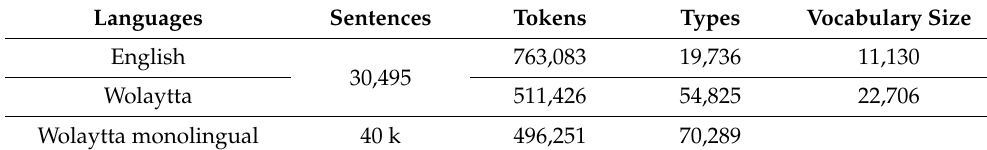
Table 2. Wolaytta–English parallel and Wolaytta monolingual dataset